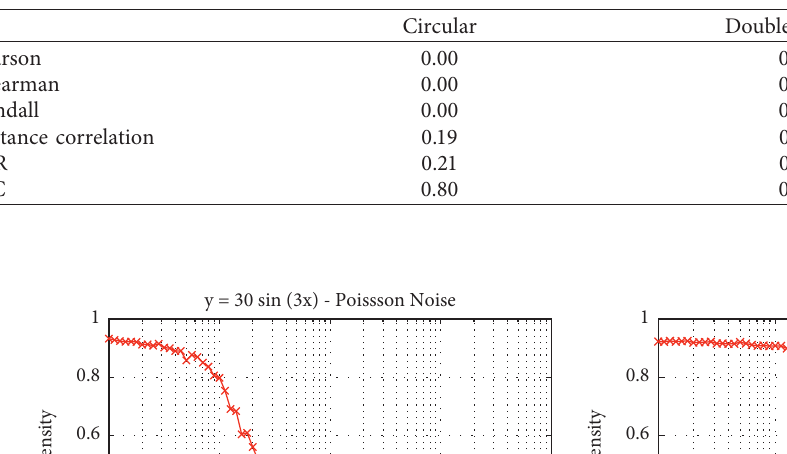
Table 2: The value of the various indicators for the case of Figure 4.